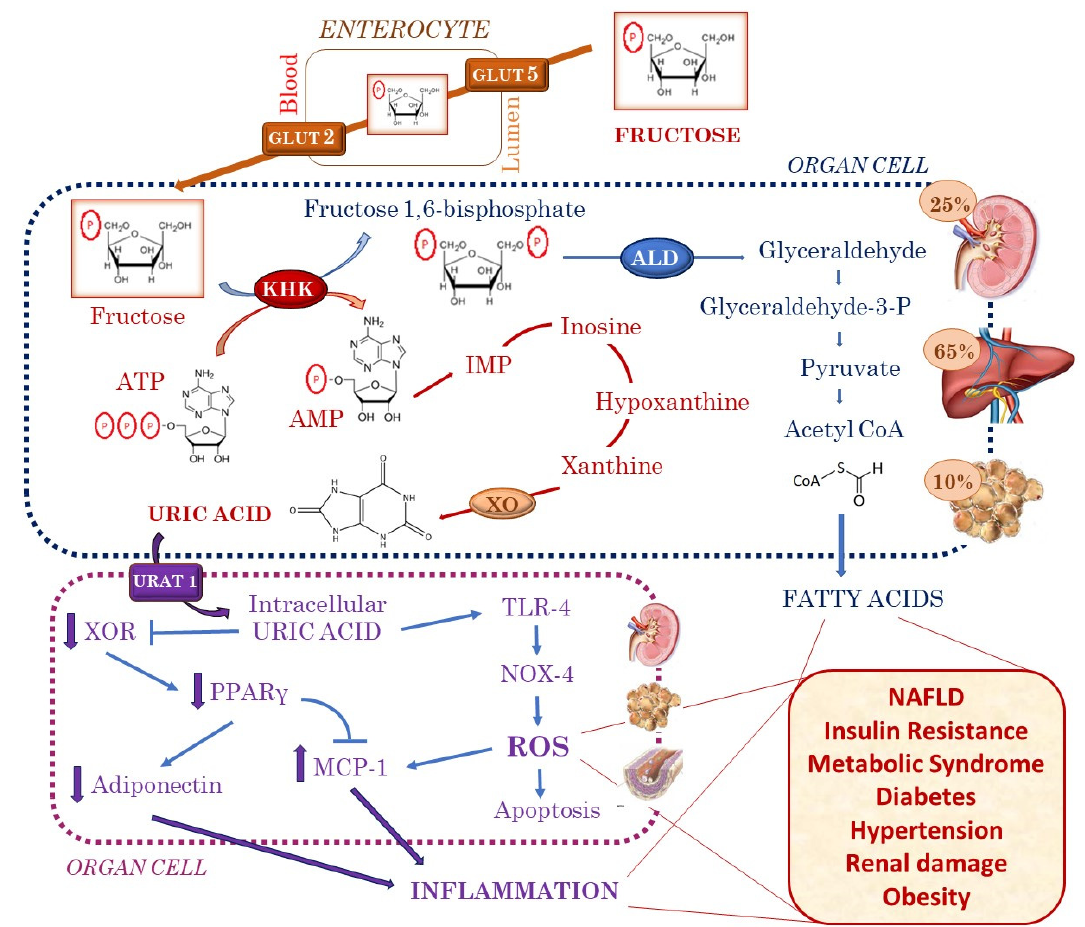
Figure 1. Fructose metabolism: direct effects and those mediated by uric acid. Glut 5 and Glut 2 guide fructose transport into cells where it is metabolized to fructose 1-phosphate by fructokinase (KHK). This reaction induces ATP depletion and causes the activation of AMP deaminase, purine degradation and uric acid generation. In addition, fructose generates glycerol phosphate and acetyl coenzyme A, resulting in fatty acid formation. Uric acid enters renal tubular cells, vascular muscle cells and adipocytes through a specific transporter, URAT-1, and activates NOX, resulting in ROS being generated from superoxide production. Moreover, uric acid can increase the production of MCP-1 and cause a decrease in the production of adiponectin, with a consequent pro-inflammatory response. Uric acid contributes to a pro-inflammatory state, mediated by toll-like receptor 4 with Nox4 up-regulation, promoting apoptosis in human cells. The production of fatty acids, oxidation, inflammation and pro-apoptotic pathways leads to several clinical manifestations, like NAFLD, insulin resistance and metabolic syndrome, diabetes, hypertension, obesity and renal damage, contributing to the increased cardiovascular risk from childhood. Abbreviations: GLUT 2, glucose transporter 2; GLUT 5, glucose transporter 5; KHK, fructokinase; ATP, adenosine triphosphate; AMP, adenosine monophosphate; IMP, inosine monophosphate; ALD, aldolase; XO, xanthine oxidase; XOR, xanthine oxidoreductase; PPAR γ , peroxisome proliferator-activated receptor gamma; URAT1, uric acid transporter 1; ROS, reactive oxygen species; MCP 1, monocyte chemoattractant protein 1; Nox 4, NADPH oxidase 4; TLR 4, toll like receptor 4; NAFLD, non-alcoholic fatty liver